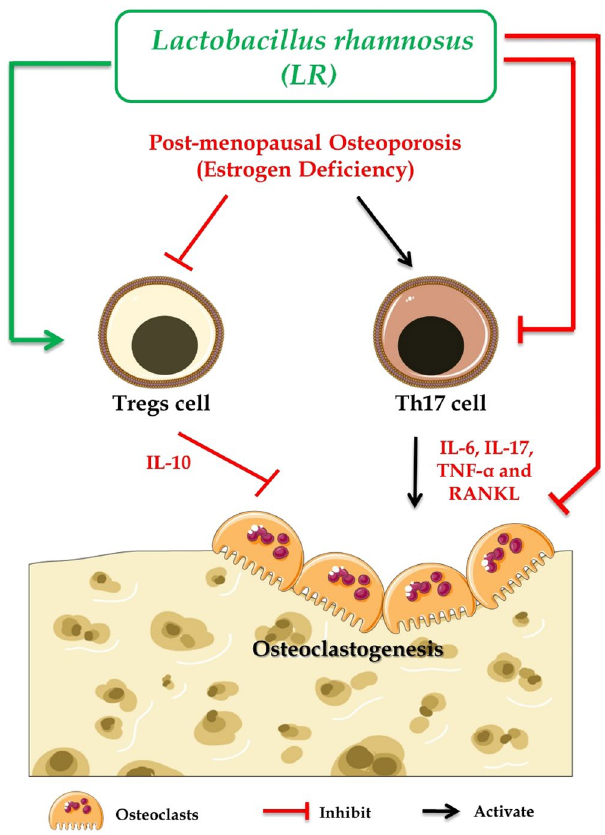
Figure 11. Summary of our results: LR administration attenuates bone loss via inhibiting osteoclasts and modulating the Treg-Th17 cell balance under both in vitro and in vivo conditions. (Image illustrated using Medical Art https ://smart .servi